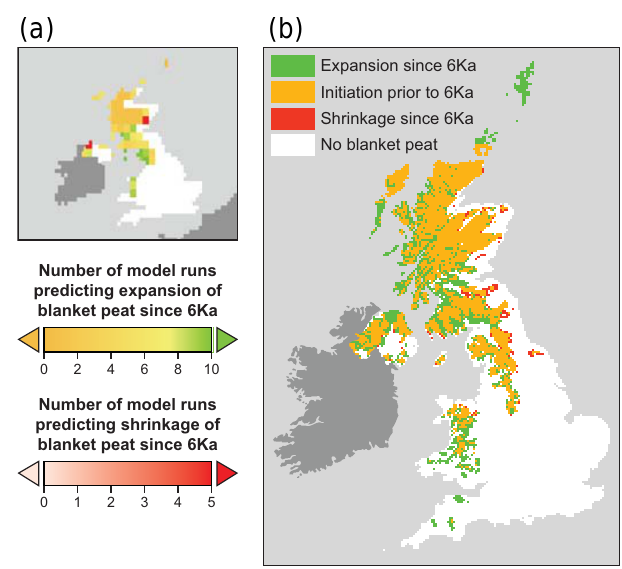
Figure 2. PeatStash simulations of blanket peat extent at 6ka using (a) simulated palaeoclimate and (b) pollen-based reconstructions of palaeoclimate.